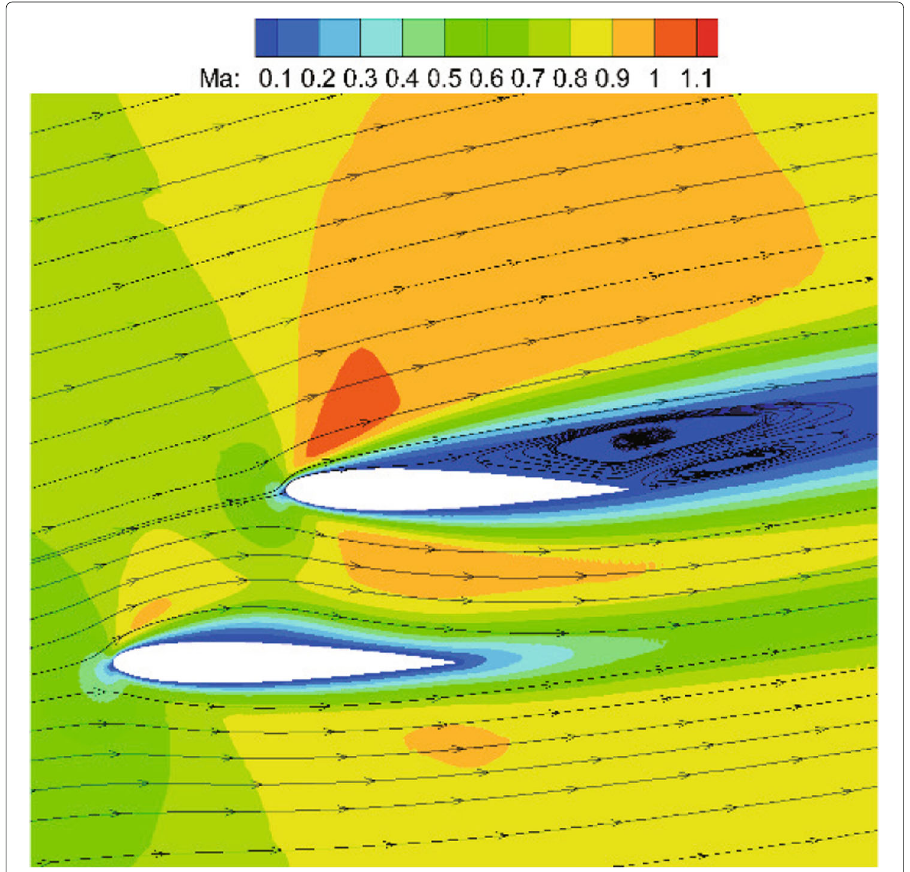
Fig. 17 Mach number contours with streamlines and separation around the top